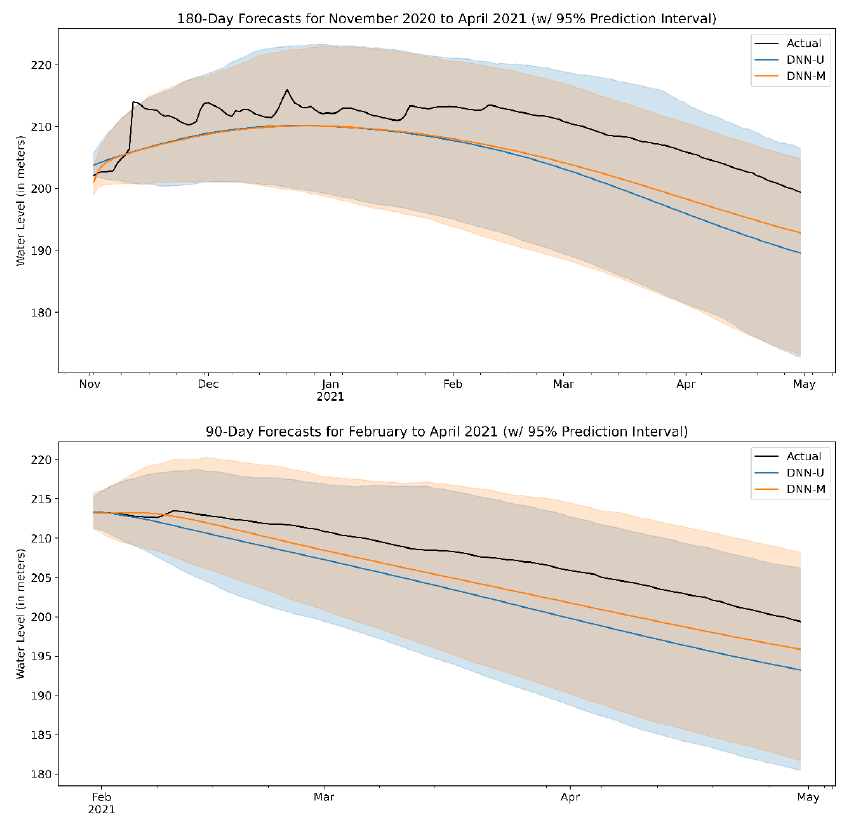
Figure 12. Sample 180-day and 90-day forecasts for the DNN models with 95% prediction intervals estimated using bootstrapped residuals.